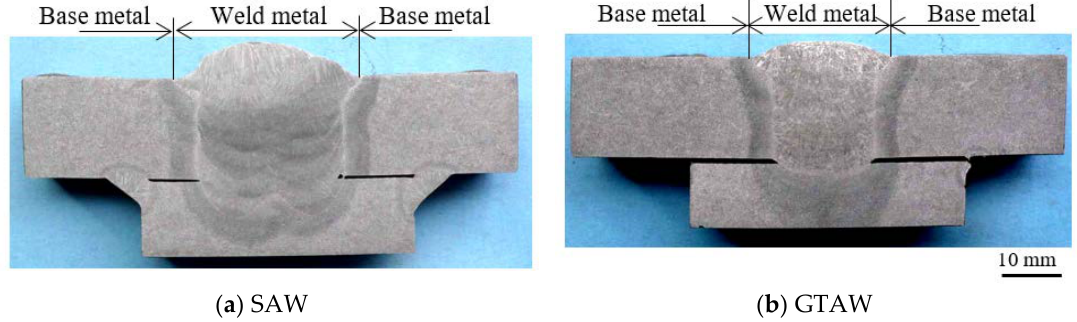
Figure 13. Macrostructures of cross-sections of submerged arc welding (SAW) ( a ) and gas tungsten arc welding (GTAW) ( b ) weld joints.